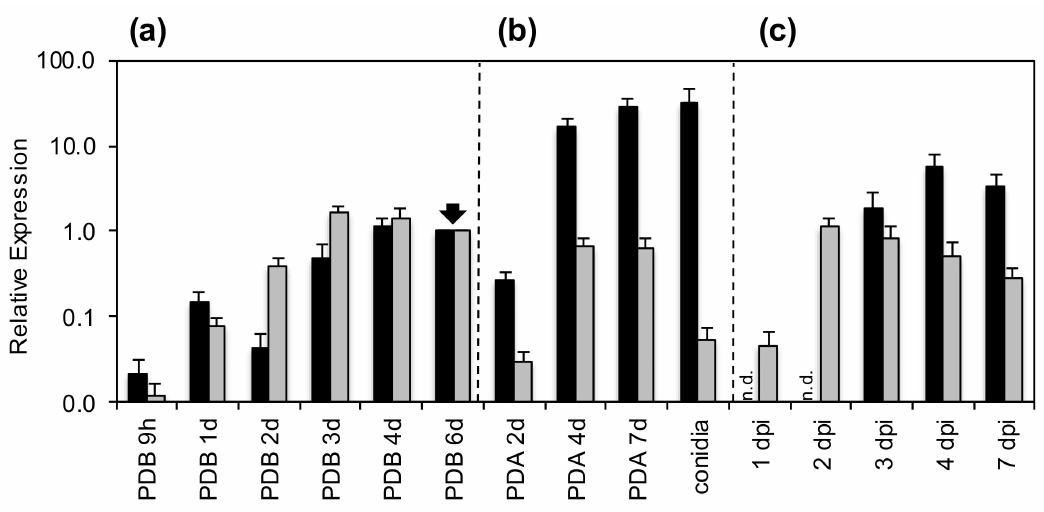
Figure 2. Relative expression of afpB and sca genes. Relative expression of P. digitatum afpB (black bars) and sca genes (gray bars) over di ff erent times of growth in: ( a ) liquid medium (PDB), ( b ) solid medium (potato dextrose agar (PDA)) and conidia and ( c ) during infection of citrus fruits. Gene expression for each condition was normalized independently to the expression at day 6 in PDB, marked by a black arrow. n.d, expression of afpB not detected in these infection samples. dpi, days post-inoculation. Bars show the means ± standard error (SE) of three technical replicates. Note the logarithmic scale for Y